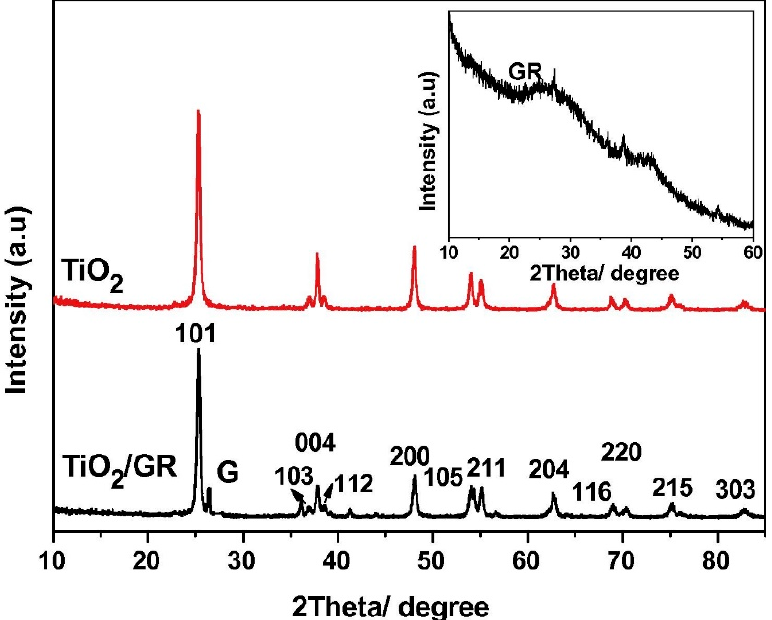
Figure 11. XRD diffractogram of TiO 2 , TiO 2 /reduced G (GR) nanocomposites and bare GR (inset). Reprinted with permission from reference [93]. Copyright 2014 Elsevier.